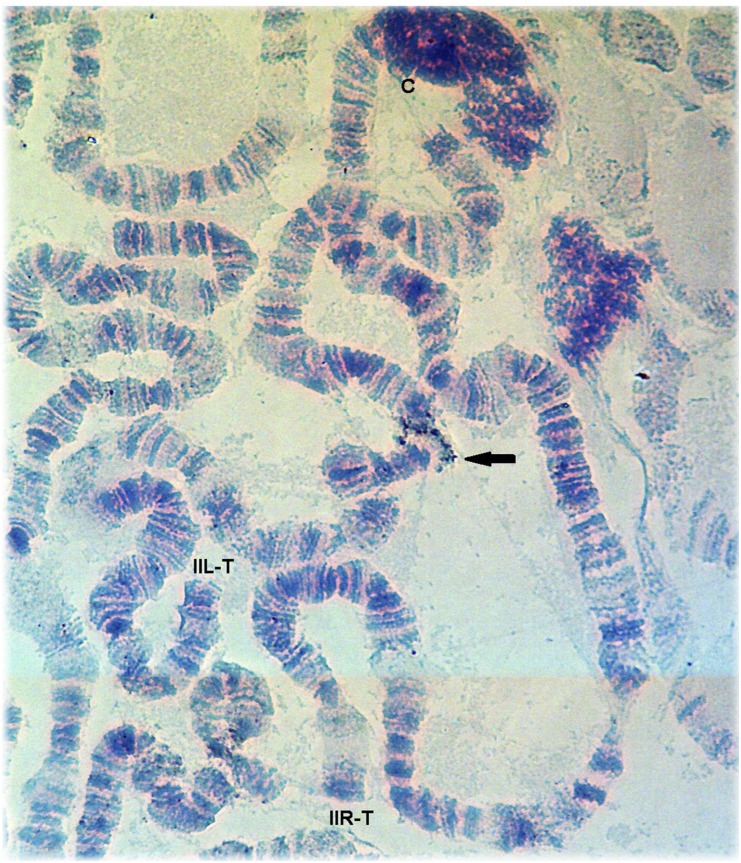
In situ hybridization of the gene probe of Adh (scaffold 4577) in Drosophila willistoni. In the present study, this gene hybridized to section 44A in chromosome arm IIL, in contrast to what was reported in previous studies (Lakovaara and Saura 1972; Rohde et al. 1995). The image shows chromosome II with the two arms IIL and IIR intact for analysis. The black arrow indicates the site of the single hybridization signal. IIL-T, IIL arm telomere; IIR-T, IIR arm telomere; C, chromocenter.